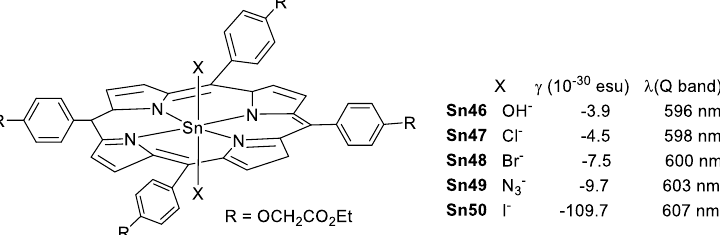
Figure 49. Structure of tin(IV) porphyrins with different axial ligands, γ and λ max (nm) values.